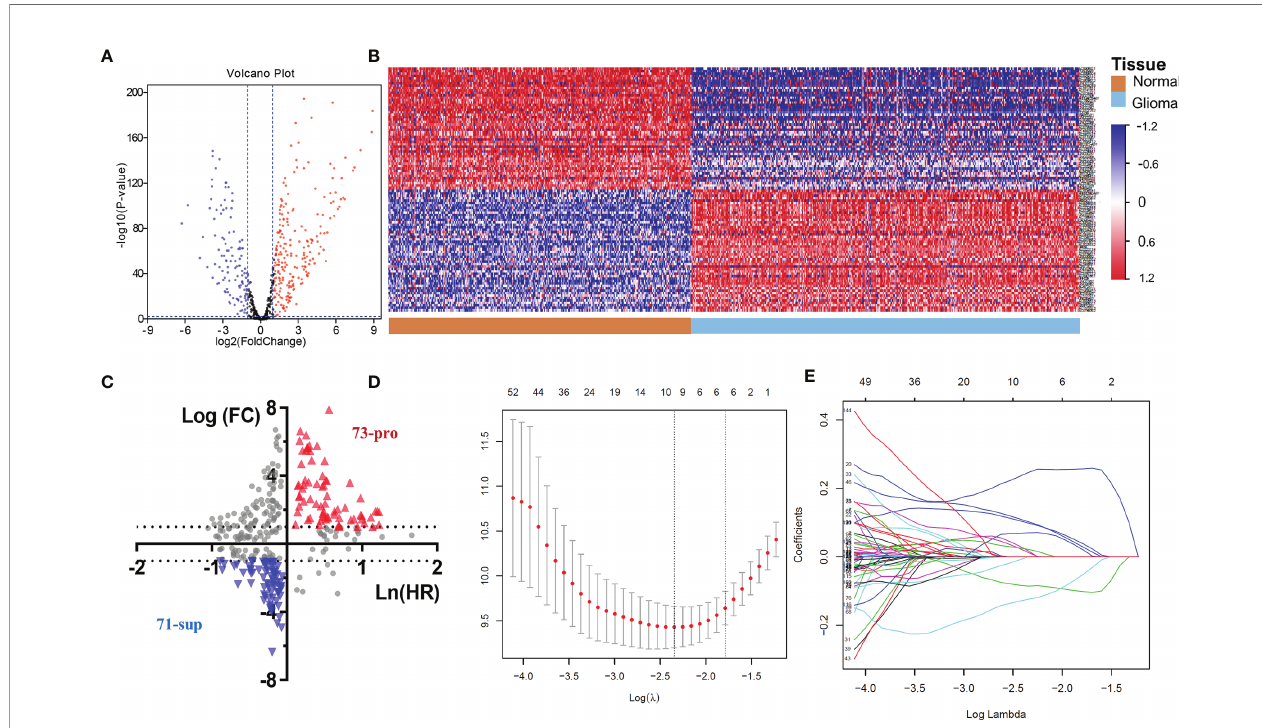
FIGURE 4 | (A) The volcano plot of m6A-related lncRNAs in glioma. (B) Heatmap of the 100 top differentially expressed m6A-related lncRNAs. (C) The 144 key m6A-related lncRNAs. (D-E) LASSO Cox regression analysis of m6A-related